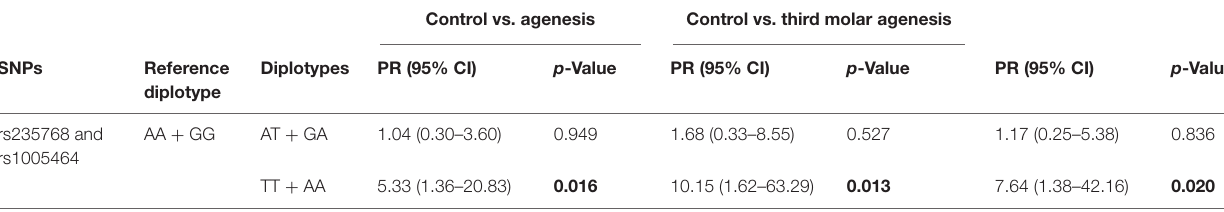
TABLE 5 | Diplotype analysis with BMP2 gene SNPs by Poisson regression adjusted by gender and ethnicity. Control vs. agenesis Control vs. third molar